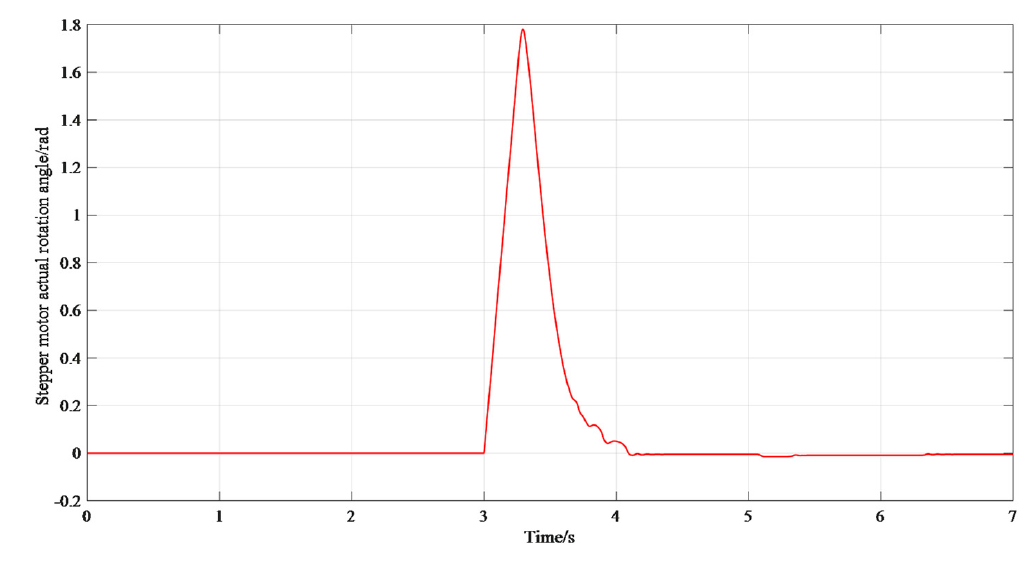
Figure 13. Response effect of incremental PID-based automatic control system of cutter height off the ground when the harvester suddenly crosses a ditch.